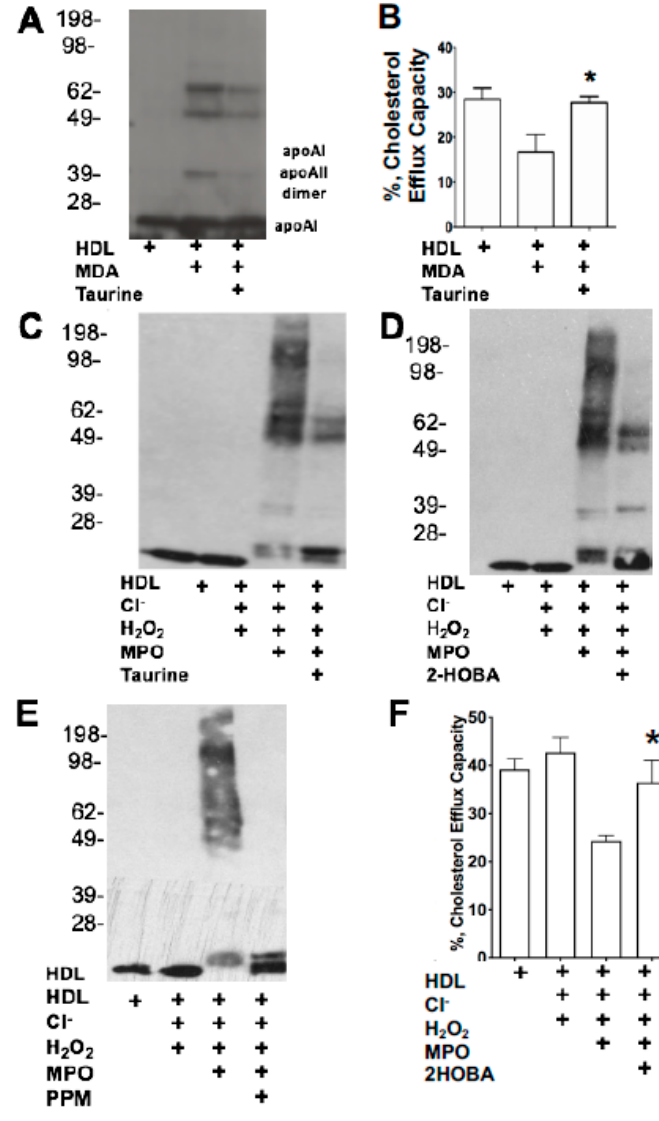
Figure 3. Effects of reactive dicarbonyl scavenging on HDL-apoAI crosslinking and cholesterol efflux capacity during MDA modification and MPO-mediated oxidation. ApoAI crosslinking ( A ) and cholesterol efflux capacity ( B ) were determined in HDL-treated with or without 5 mM taurine before the addition of MDA (250 μ M MDA). The ability of reactive dicarbonyl scavenging with 5 mM taurine ( C ), 500 μ M 2-HOBA ( D ), or 500 μ M PPM ( E ) to prevent MPO-HDL-apoAI crosslinking was determined. The cholesterol efflux capacity of HDL modified with MPO in the absence and presence of 2-HOBA was measured in J774 cells ( F ). Graphs represent data (mean ± SEM) of the experiments; * p < 0.05 is indicated by comparing with MDA-HDL group ( B ) and with MPO-mediated HDL oxidation group ( F ) by one way ANOVA.